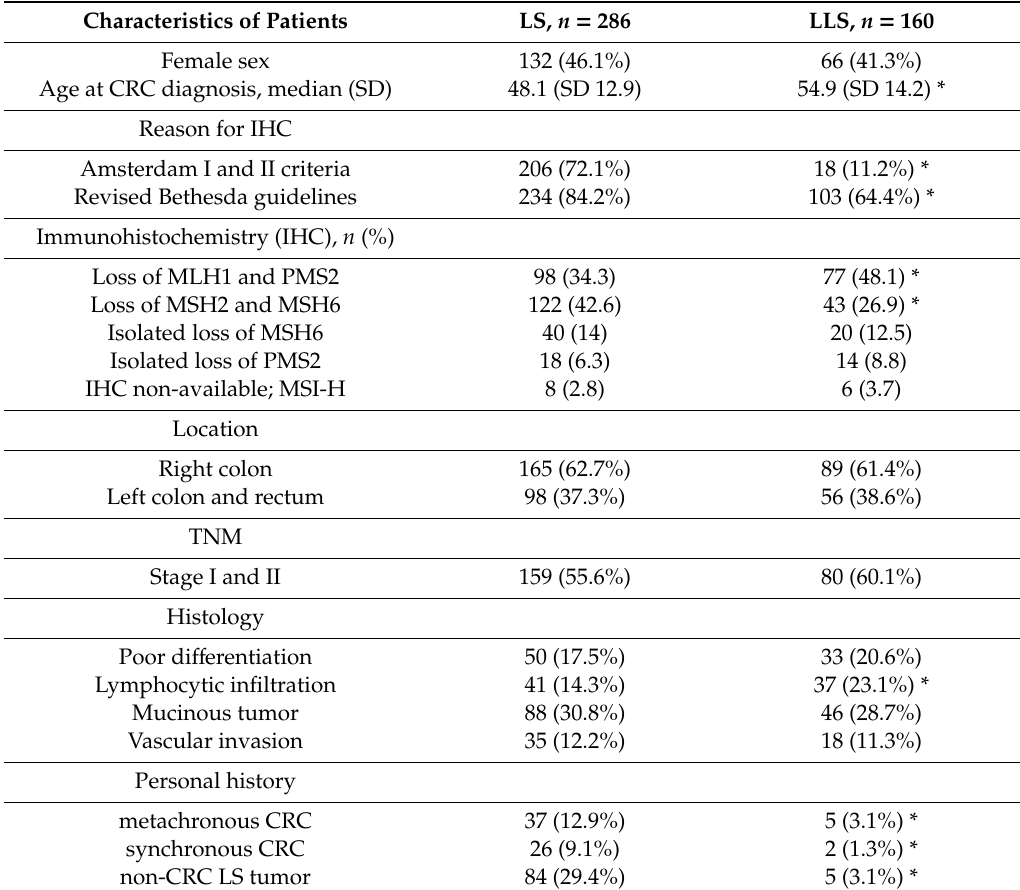
Table 1. Characteristics of patients with LS and LLS.